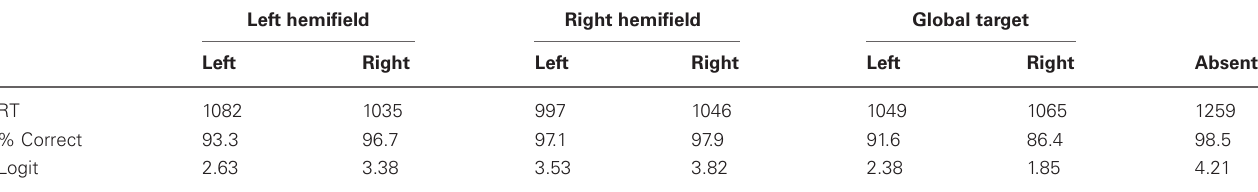
Table 1 | The pattern of performance observed for 12 neurologically healthy individuals, reporting the response time (RT, in ms derived from mean log RT), percent accuracy (% Correct) and logit